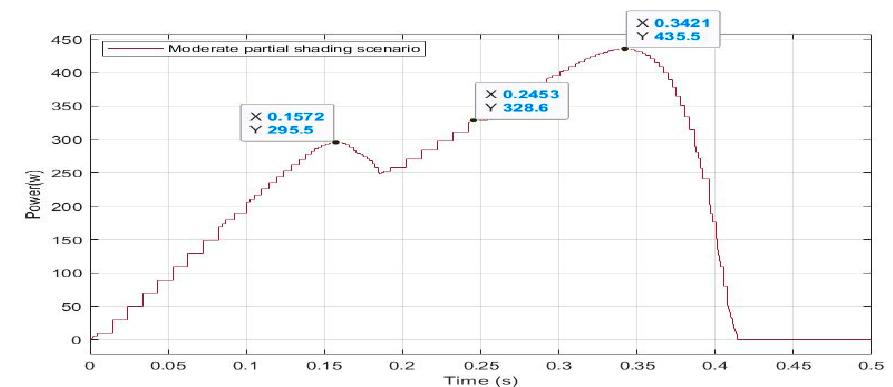
Figure 9. Scenario of Case Two (Moderate partial shading pattern).